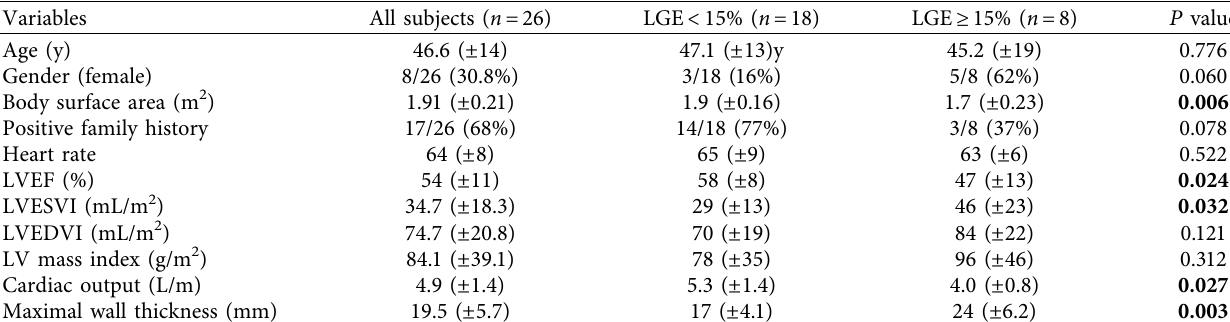
Figure 2: (a) Late gadolinium enhancement sequence (magnitude image), (b) late gadolinium enhancement sequence (phase image), (c) ADC map, and (d) true FISP image in a known case of hypertrophic cardiomyopathy. ADC: apparent diffusion coefficient; FISP: fast imaging with steady-state free precession. Table 1: Baseline demographic and cardiac MRI characteristics of the study